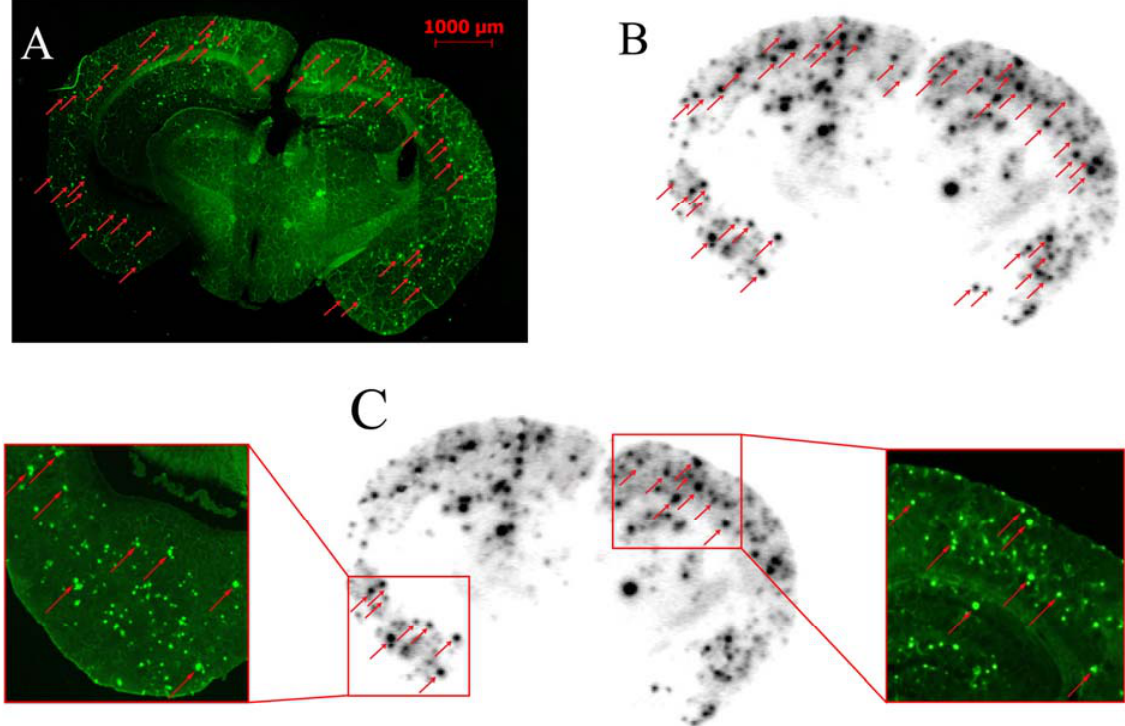
Figure 5. The presence and distribution of plaques in the sections were confirmed with thioflavin-S staining ( A , C ) (red arrows); Autoradiography of [ 125 I] 8 in vitro in Tg model mouse (APP/PS1, 12 months, male) brain sections ( B